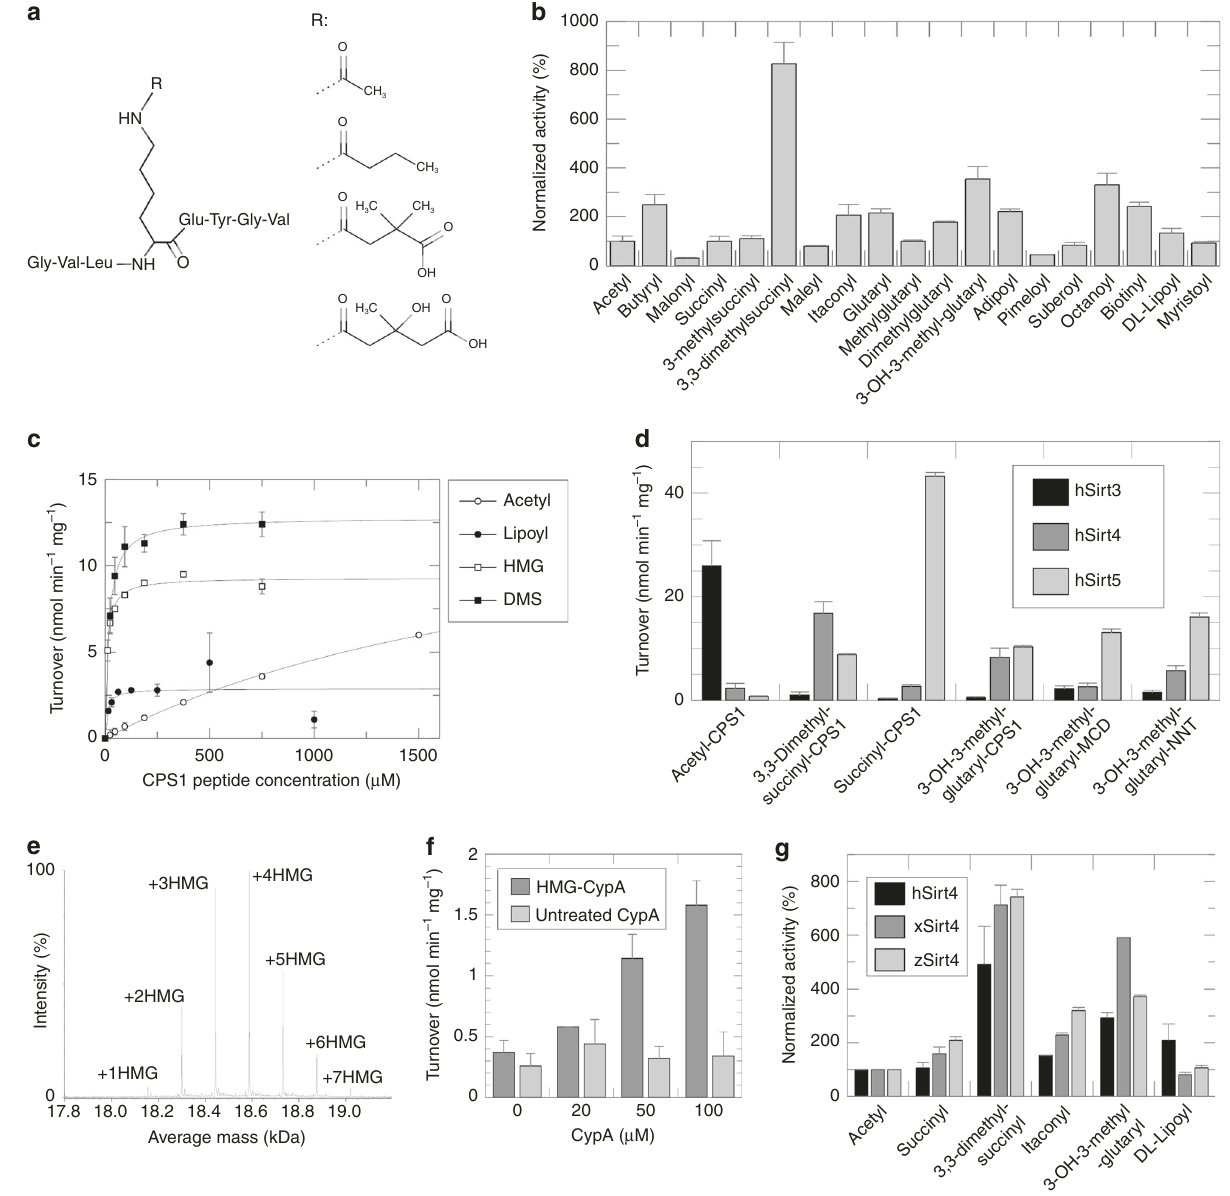
Fig. 1 Sirt4 deacylation activities. a Chemical structures of CPS1 peptide and Lys acylations; from top: acetylation, butyrylation, DMS-ylation, HMG- ylation. For the complete set of acyl modi fi cations see Supplementary Fig. 1a. b Sirt4-dependent deacylation of differently acylated CPS1 peptides. ( n = 2; error bars: s.d.). c Sirt4 titrations with CPS1 substrate peptide carrying an acetyl, lipoyl, HMG, or DMS modi fi cation, respectively. ( n = 2; error bars: s.d.). d Comparison of Sirt3, 4, and 5 deacylation activities against substrate peptide with acetyl, succinyl, DMS, or HMG modi fi cation, respectively. ( n = 2; error bars: s.d.). e Intact protein mass spectrometry of HMG-ylated CypA (unmodi fi ed molecular weight 18,012 Da). f Sirt4-dependent deacylation reactions with increasing amounts of untreated and HMG-ylated CypA protein, respectively, as a substrate. ( n = 2; error bars: s.d.). g Comparison of the